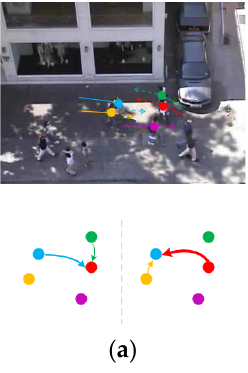
Figure 7. Sparse direct interaction visualization in different scenes. Solid lines represent observed trajectories, colored dots indicate the current location, and the dash lines represent the trajectories in the future. ( a ) The scene in ZARA1. ( b ) The scene in ETH. ( c ) The scene in HOTEL.